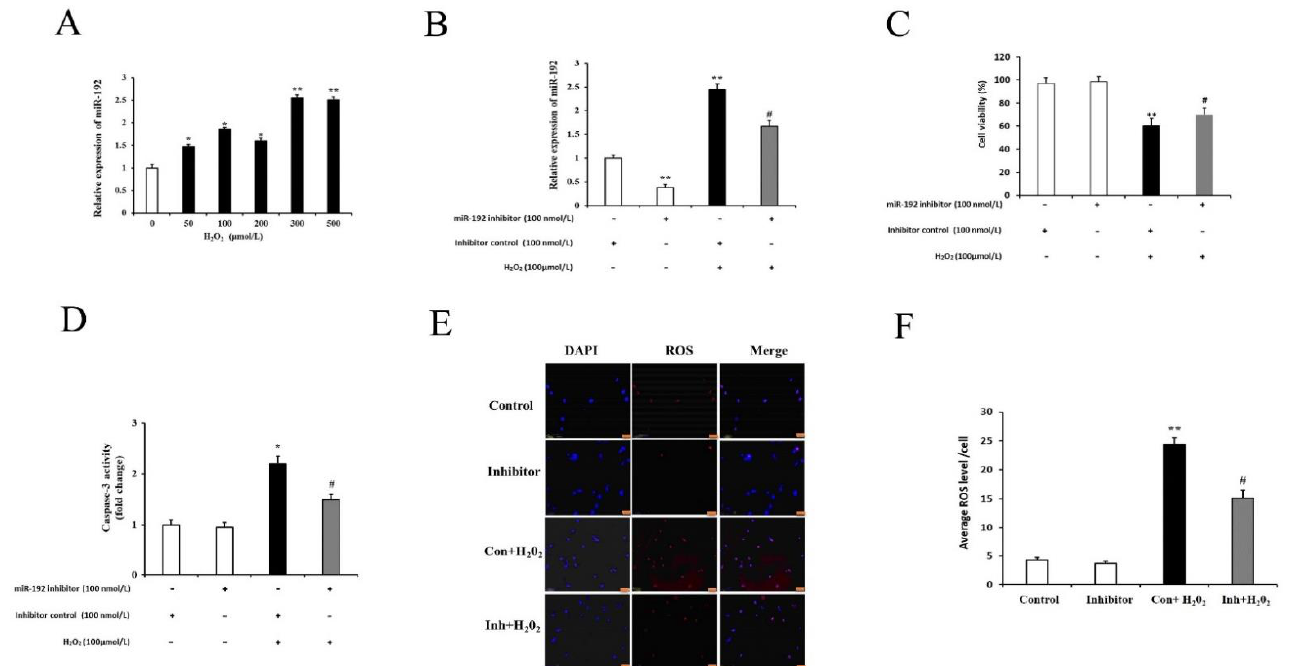
Figure 8. Downregulation of miR-192 alleviates H 2 O 2 -induced PGC injury. ( A ) The expression levels of miR192 in cultured PGCs were measured after 12 h of exposure to different H 2 O 2 concentrations. ( B ) Transfection with miR-192 inhibitor decreased PGC miR-192 levels significantly. ( C ) Effects of miR-192 downregulation on PGC proliferation. ( D ) Effects of miR-192 downregulation on caspase-3 activity. ( E ) Effects of miR-192 downregulation on intracellular ROS levels, scale bars correspond to 50 µ m. ( F ) Quantification of intracellular ROS levels. Each value is expressed as the mean ± S.E. ( n = 3). * p <0.05 and ** p < 0.001 vs. con; # p < 0.01 Inh + H 2 O 2 vs. con+ H 2 O 2